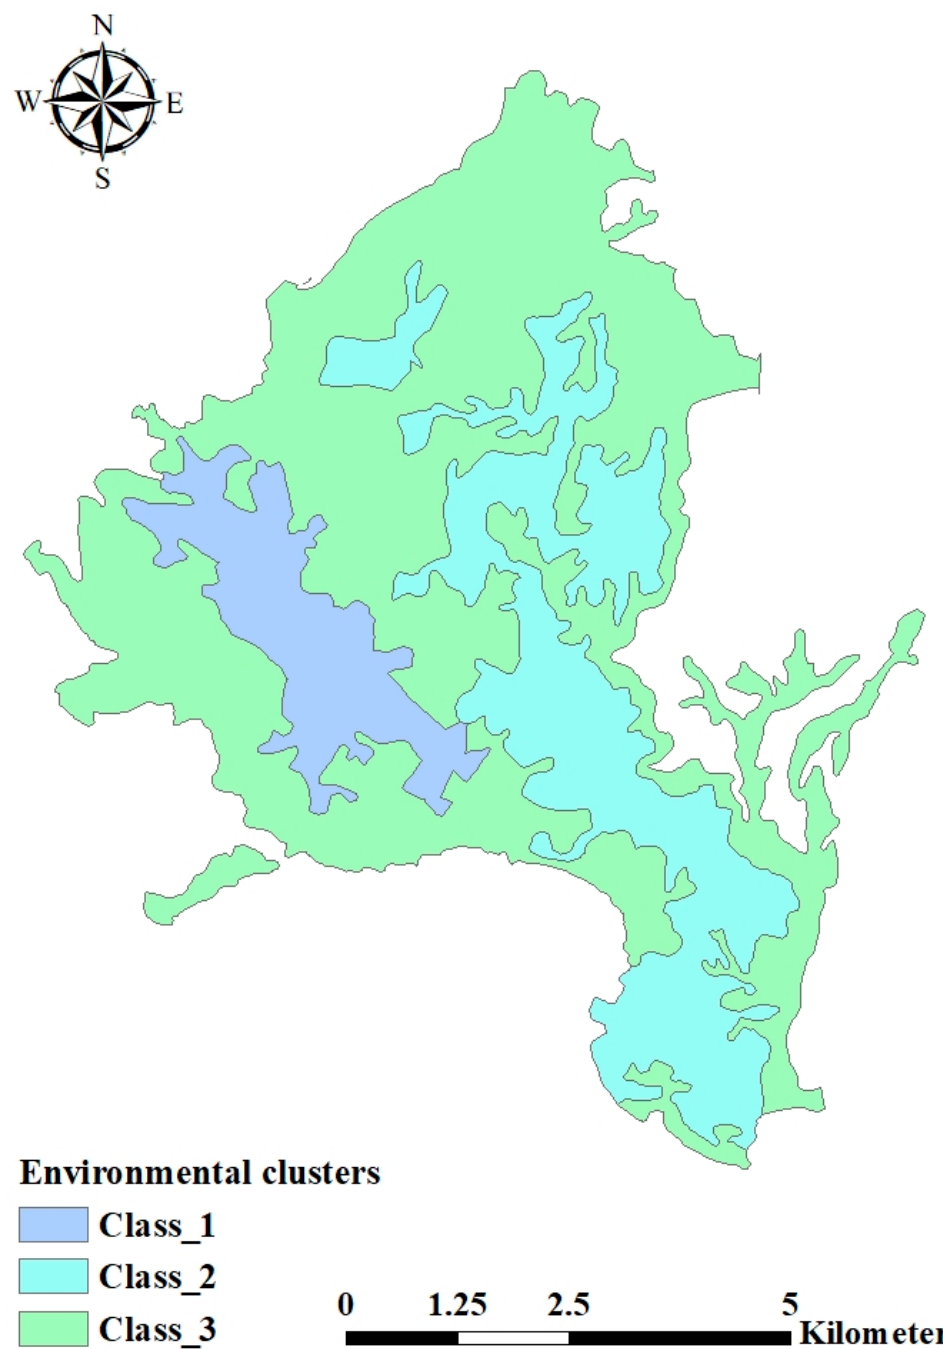
Figure 3. Environmental clusters of the designated study area. Table 5. The overlap percentages between the environmental cluster and Land Use Land Cover classes.